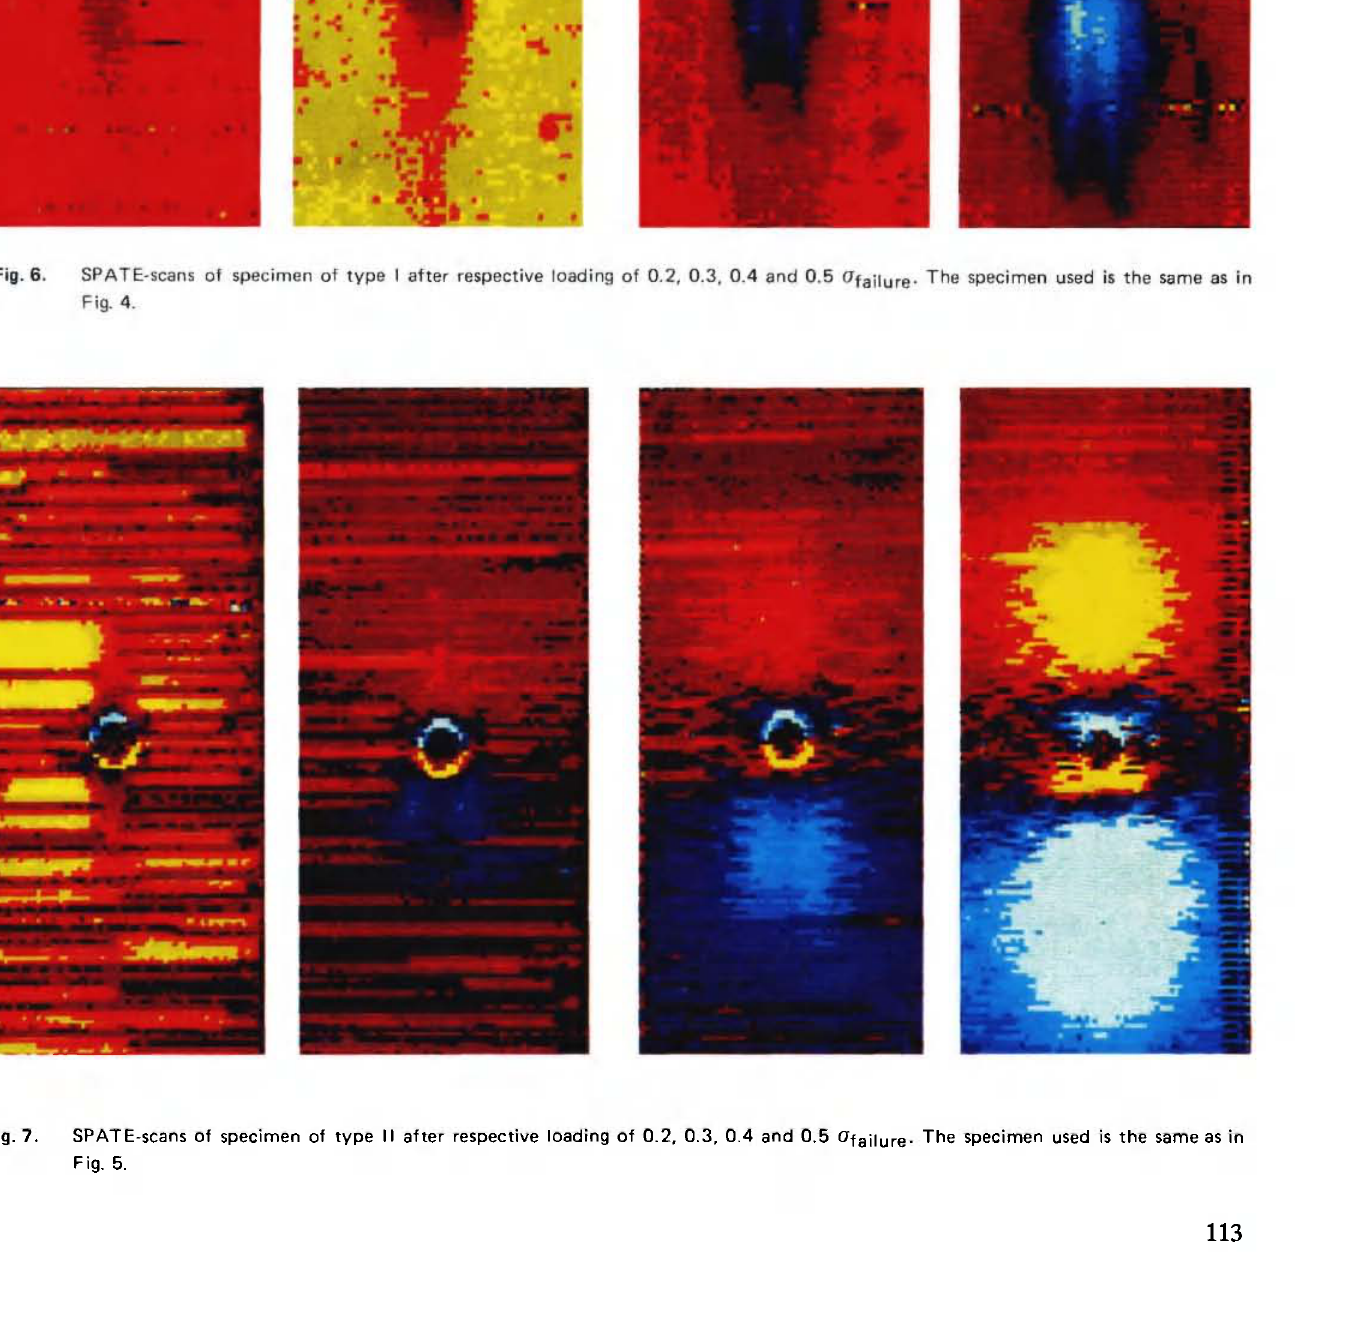
Fig. 7. SPATE-scans of specimen of type II after respective loading of 0.2, 0.3, 0.4 and 0.5 Of a ilure- The specimen used is the same as in Fig. 5.